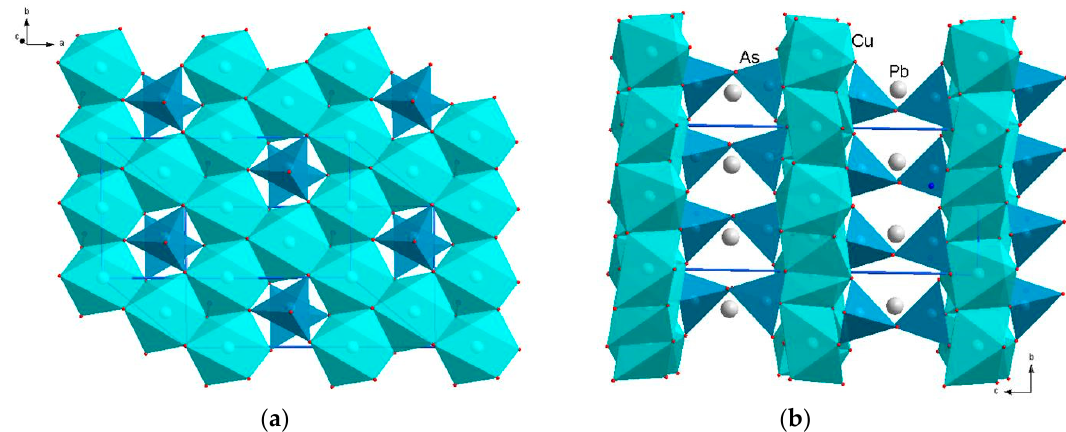
Figure 9. The crystal structure of vésignéite, BaCu 3 (OH) 2 [VO 4 ] 2 in projections onto the ab ( a ) and bc ( b ) planes. The cationic arrangement inside the layer centering the basic block of the {(Cu,Zn) 3 (OH) 2 [AsO 4 ] 2 } composition in the monoclinic crystal structure of mineral bayl- donite, Pb(Cu,Zn) 3 (OH) 2 [AsO 4 ] 2 [37] also shows the layers with ¾ of octahedral voids populated by the Cu/Zn atoms. It corresponds to the same ordinary kagomé configura- tion as in vésignéite (Figure 3b). Along the [001] direction, these blocks (A) alternate with layers of Pb eight-vertex polyhedra (tetragonal antiprisms) (B) (Figure 10). However, differently to the similarly monoclinic (sp. gr. C 2/ m ) vésignéite structure, in the present case, the modules are twice multiplied along the c axis due to the symmetry (sp. gr. C 2/ c ), forming the ABA’B’ sequence with a period of 14 Å.